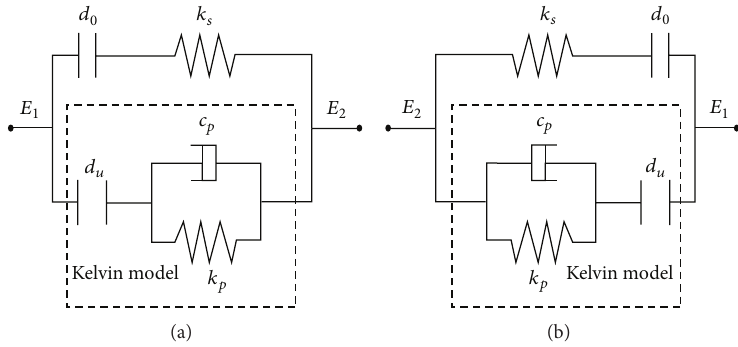
Figure 2: Mechanical model of protective system. (a) Right-sided limiting deformation; (b) left-sided limiting deformation.